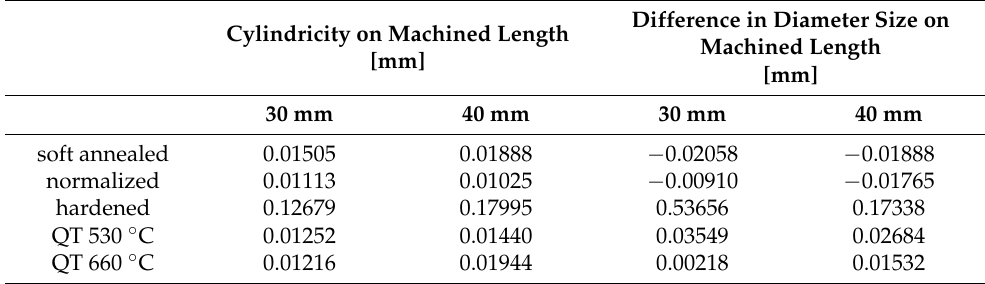
Table 7. Cylindricity and difference in diameter size of machined C45 steel